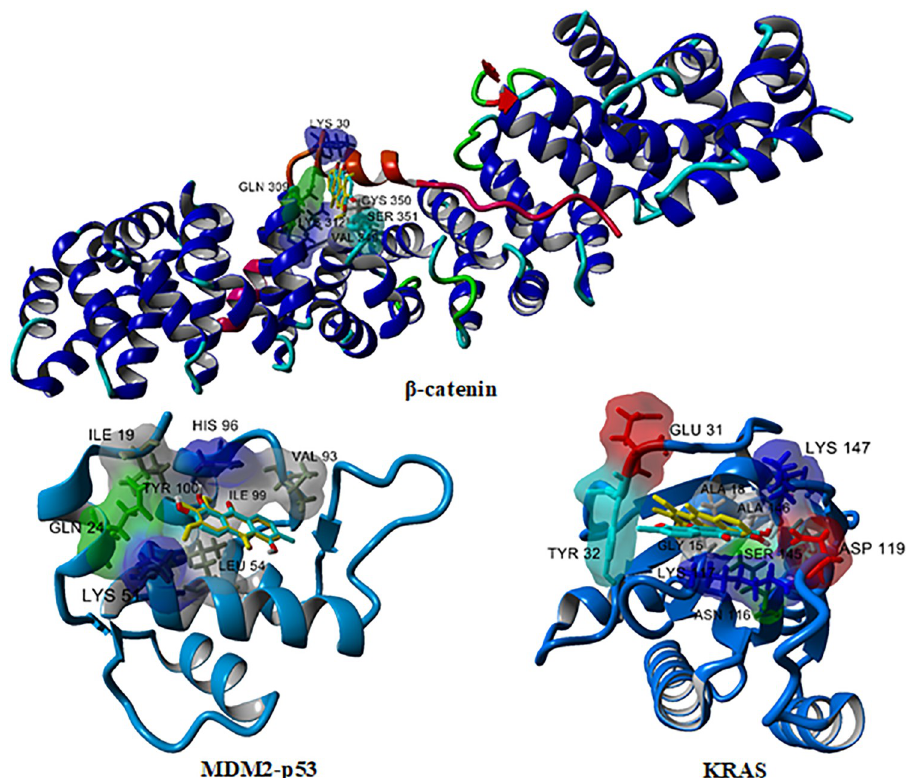
Fig 2. Docking complex of morindone (cyan) and rubiadin (yellow) against β -catenin, MDM2-p53, and KRAS. The TCF cofactor in β -catenin was shown in red. Molecular surface regarding residues type at the binding residues within 3 Å from compounds were illustrated. Amino acid residue types were colored by YASARA coloring scheme: nonpolar, grey; amidic, green; basic, blue; acidic, red; hydroxylic,